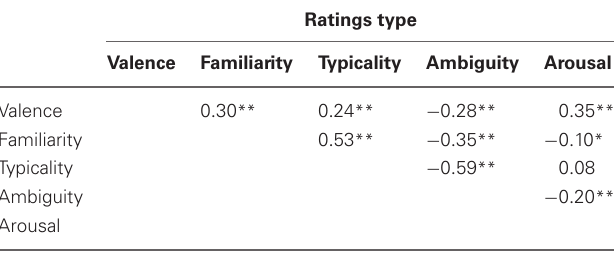
Table 4 | Correlation between validation dimensions for natural items (rotten-food, natural-non-food item, animals, and scenes, N = 207). Ratings